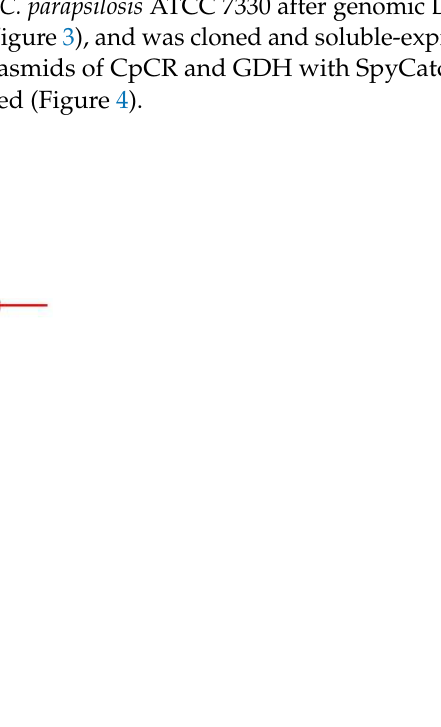
Figure 2. Agarose electrophoresis of the ATCC 7330 genome. Lane M: DNA marker. Lane 1: ATCC 7330 genome.